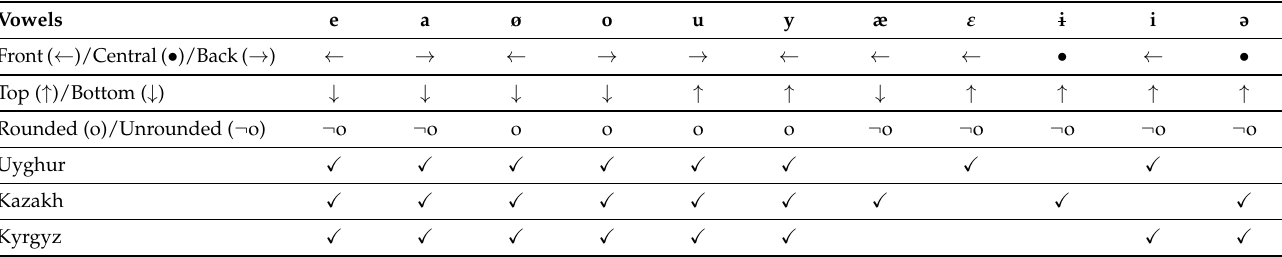
Table 2. Vowel phoneme sets of Uyghur, Kazakh, and